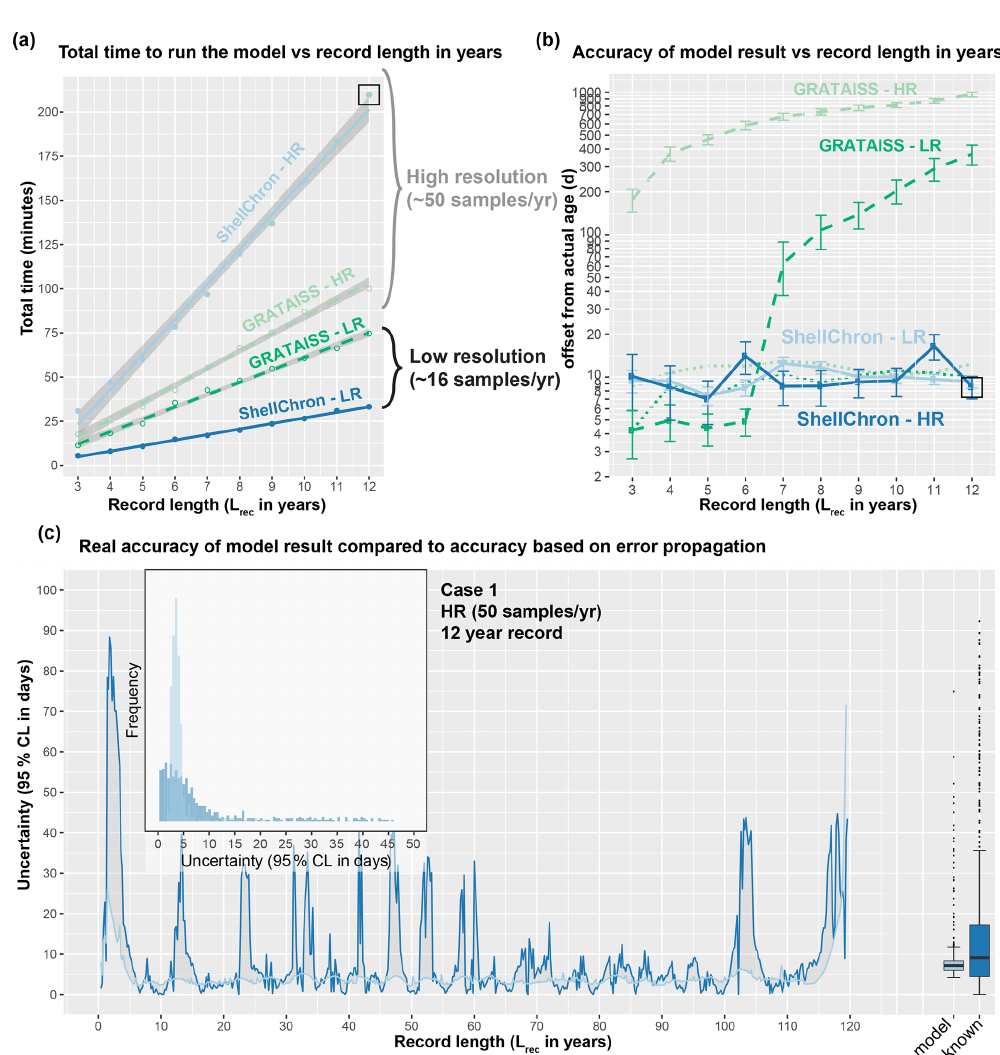
Figure 8. Overview of the result of timing ShellChron and the GRATAISS model on the same datasets (a) , comparing the accuracies of both models (b) , and comparing the accuracy as calculated by ShellChron with the known offset in the age model (c) . In (a) and (b) , low- resolution datasets are plotted in dark blue (ShellChron) and dark green (GRATAISS), while high-resolution datasets are plotted in light blue (ShellChron) and light green (GRATAISS). Solid lines represent ShellChron, and dashed lines show the performance of the GRATAISS model. Green dotted lines in (b) show the accuracies of the GRATAISS model on a year-by-year basis (without accumulating error due to linking consecutive years). The black box in (a) and (b) highlights the dataset used in (c) . In (c) , dark blue lines, bars, and box plot indicate true offset of the model from the actual sample age, while light blue lines, bars, and box plot show the accuracy of the model as calculated from the propagated errors in model and input data. Raw data are provided in